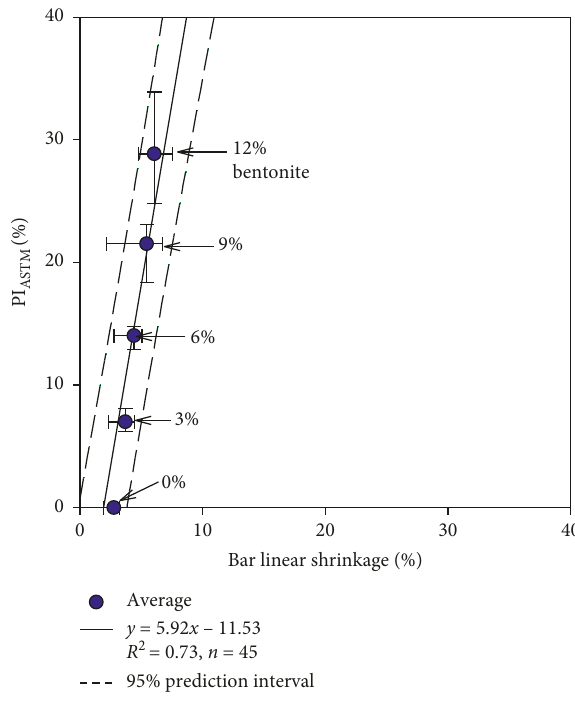
Figure 6: Correlation between BLS values and PI determined by ASTM methods (Casagrande cup for LL and plastic limit roller for PL), for five testing samples. Note. Error bars show the maximum or minimum